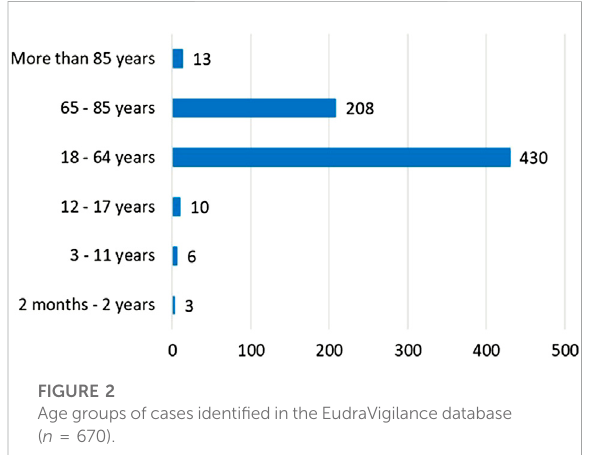
FIGURE 2 Age groups of cases identi fi edin theEudraVigilance database ( n = 670).